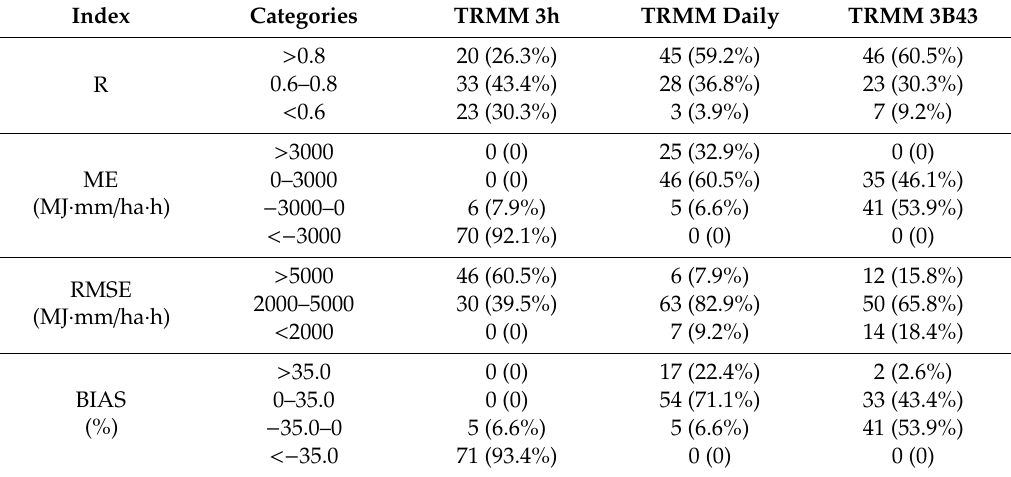
Table 3. Statistical distribution of bias of annual rainfall erosivity from TRMM 3h, daily and 3B43 rainfall